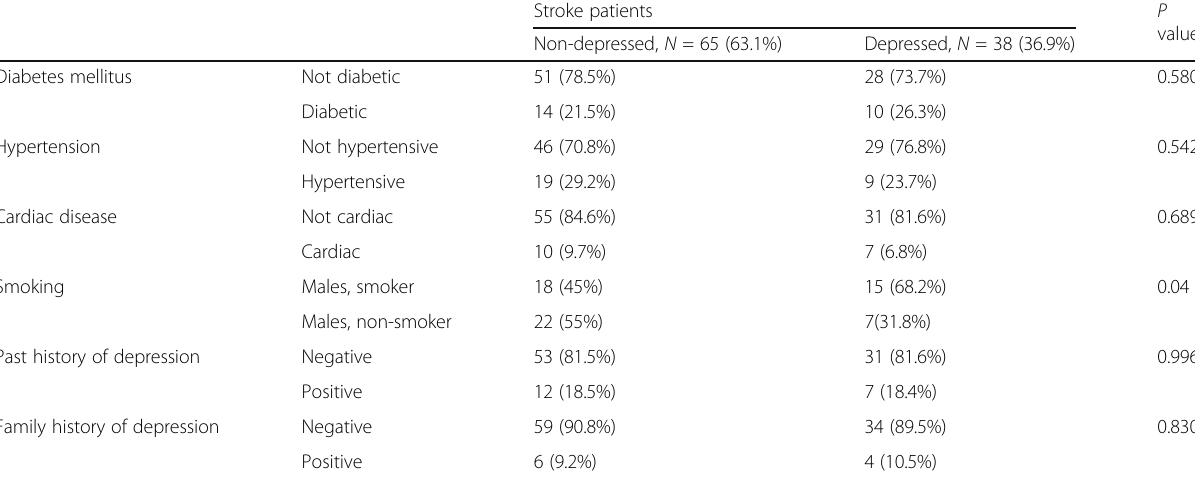
Table 3 Comorbid medical and psychiatric illness and post-stroke depression